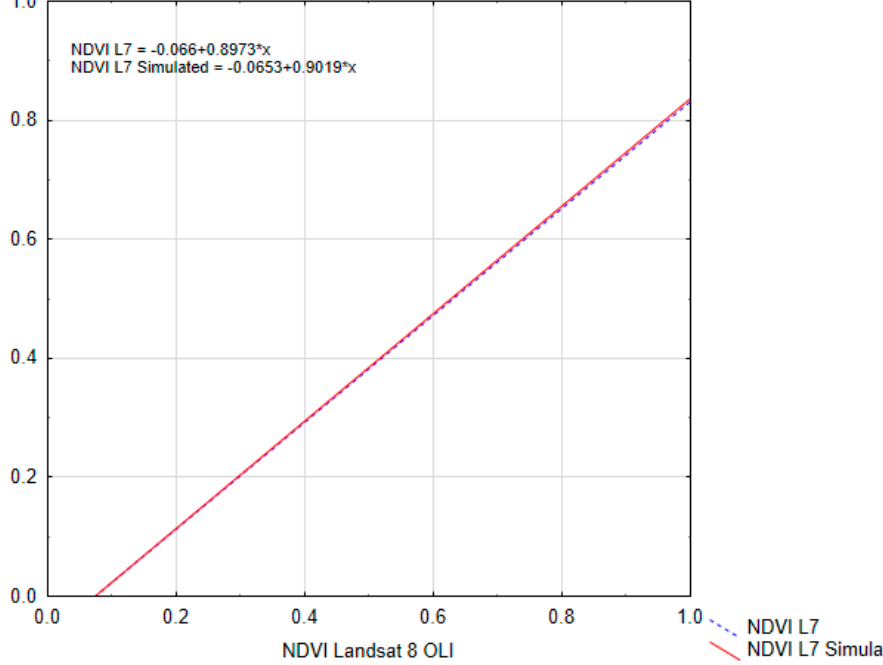
Figure 2. Regression functions between NDVI from OLI and NDVI from Landsat ETM+ and Landsat + corrected with phenological ETM+ corrected with phenological rate. ETM